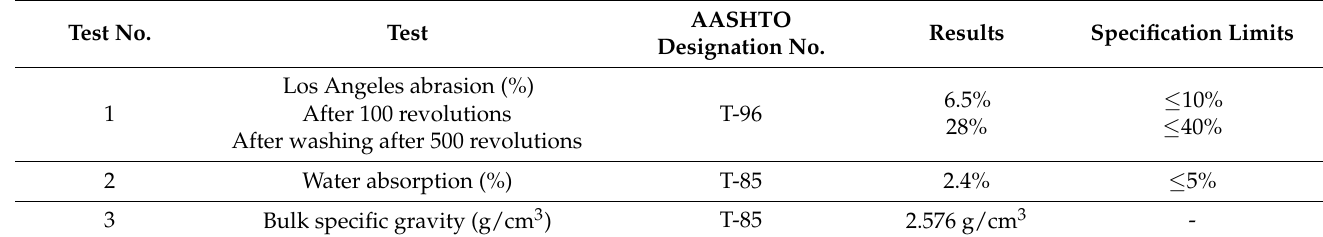
Table 2. Properties of aggregate used.